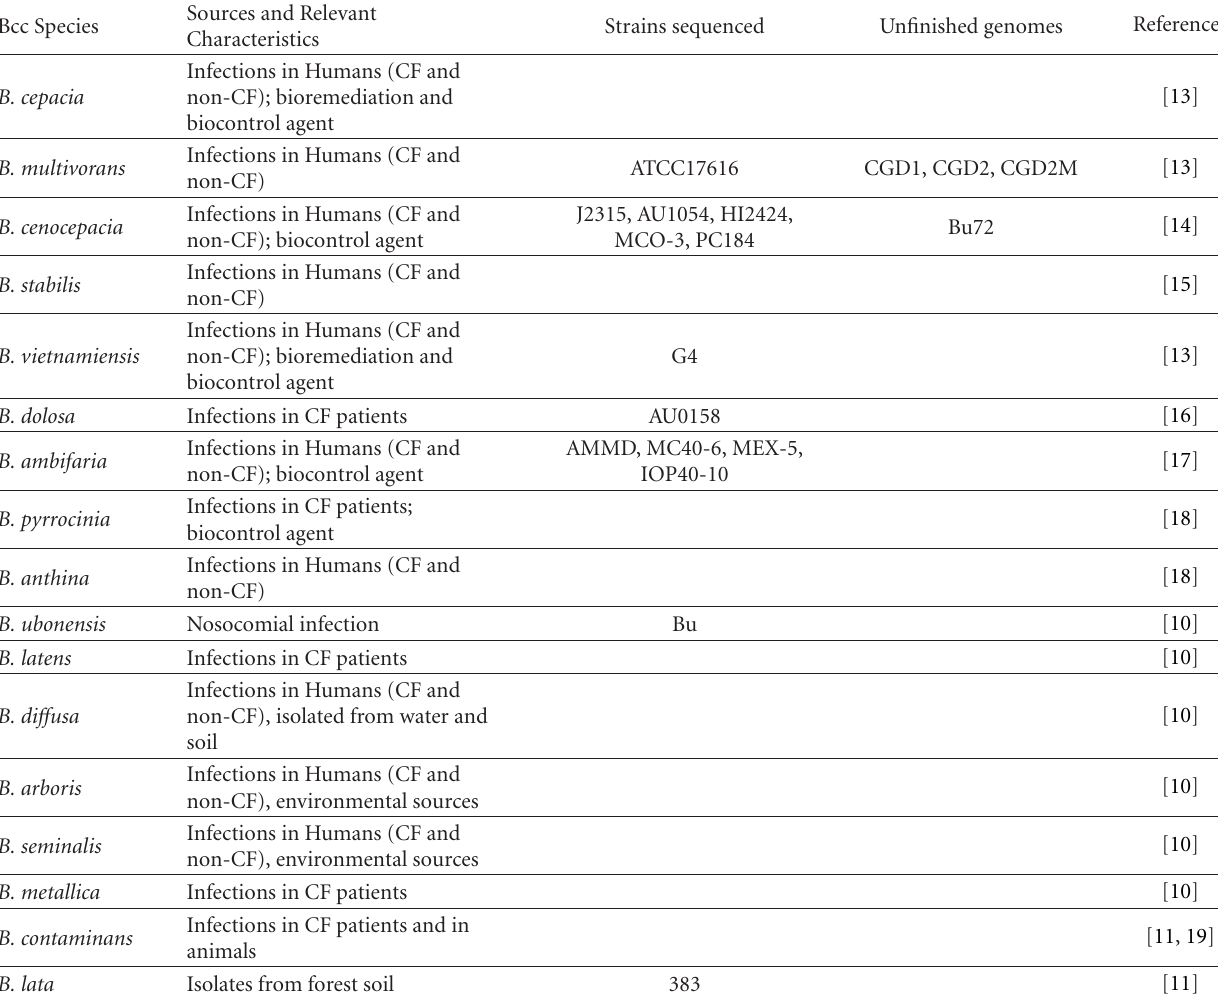
Table 1: Burkholderia cepacia complex species and strains with their genome sequences finished or in progress. The Bcc genomes here described are summarized in the Burkholderia genome database